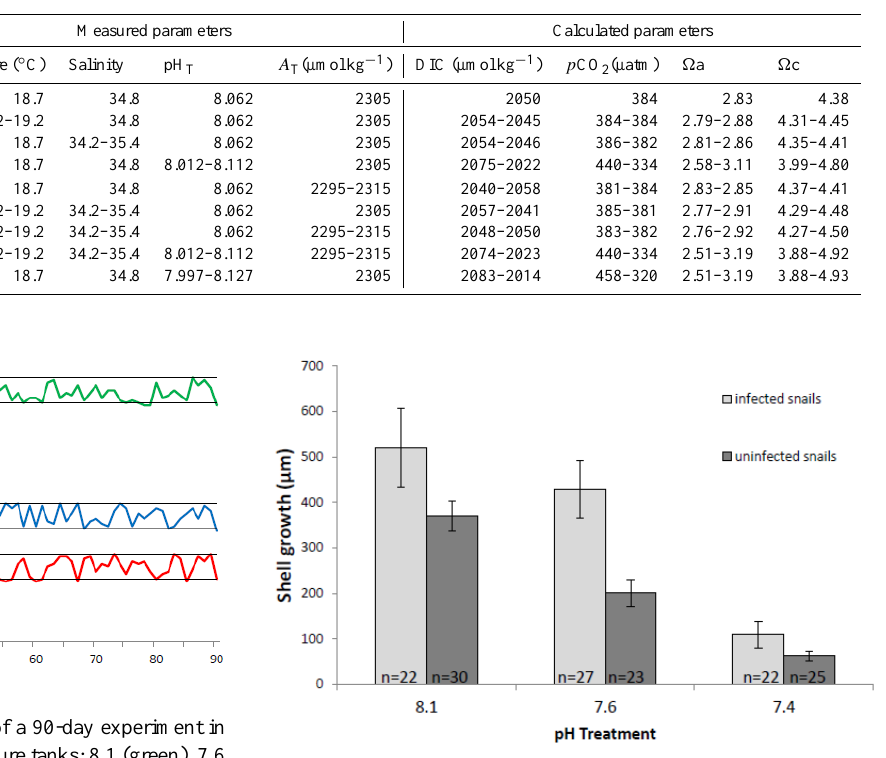
Figure 3. Average shell growth ( ± SE, sample size as indicated) of infected and uninfected snails in three pH treatment: 7.4, 7.6, Figure 3 Average shell growth (± SE, sample size as indicated) of infected and uninfected snails in three 2 pH treatment: 7.4, 7.6, 8.1. 3